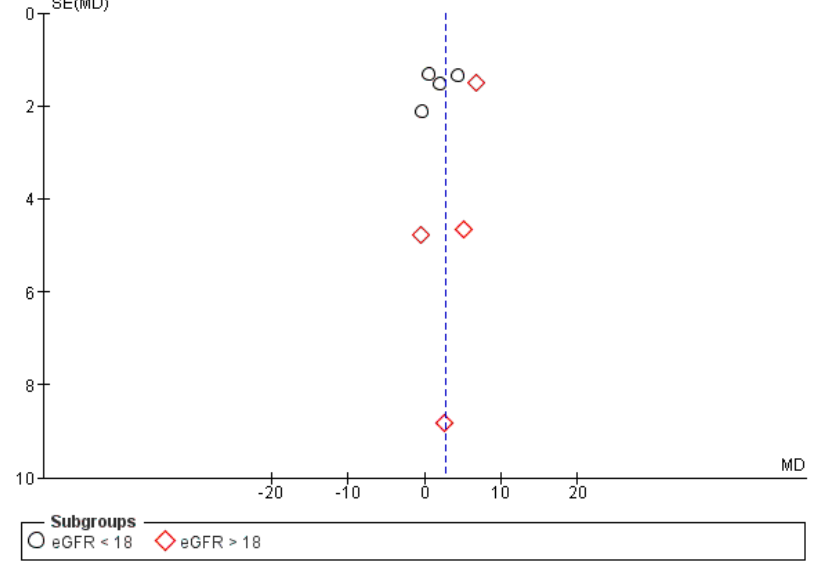
Figure 14. Funnel plot of the effects of KA on eGFR (mL/min/1.73 m 2 ) under a random model with a 95% confidence interval.